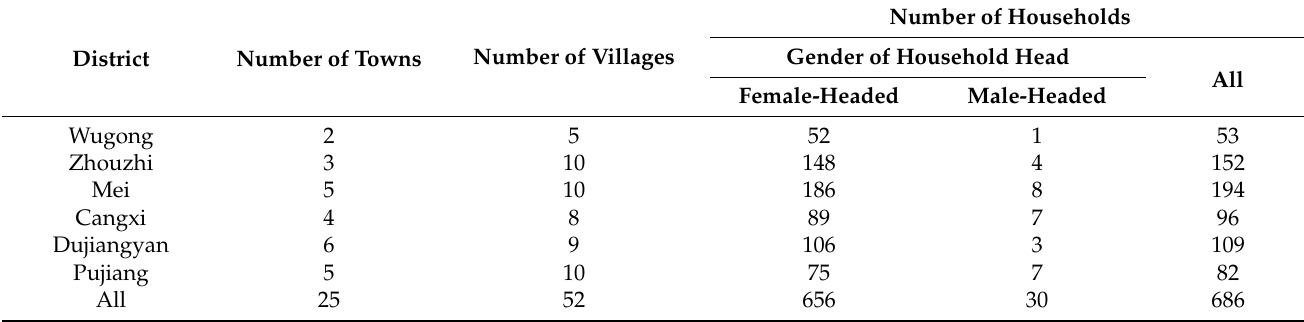
Table 1. Distribution of the sample households by district and